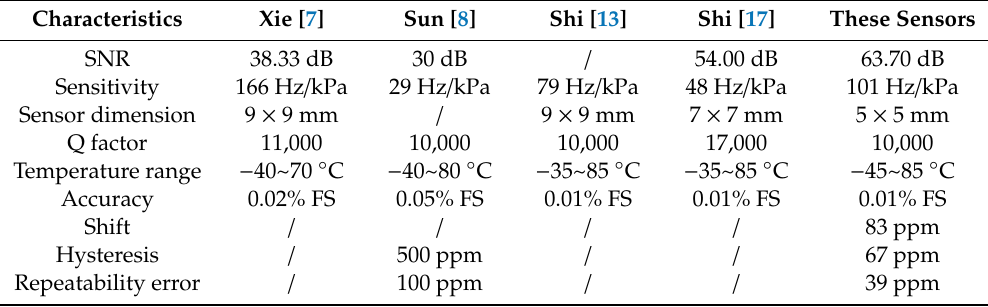
Table 2. Comparisons of the sensor